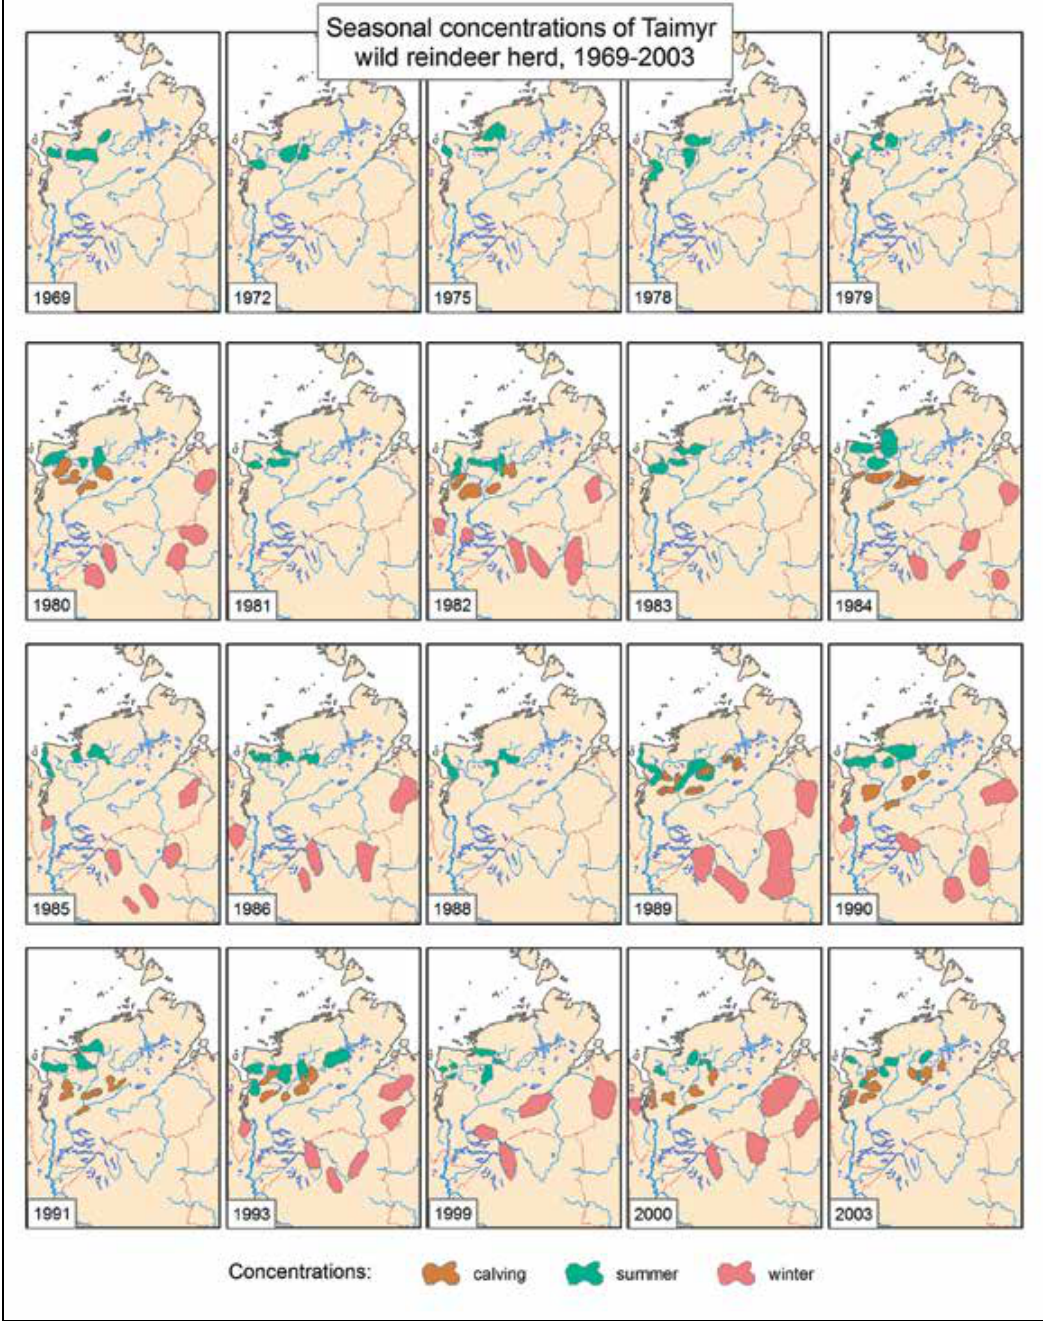
Fig. 2. Seasonal concentrations of Taimyr wild reindeer in